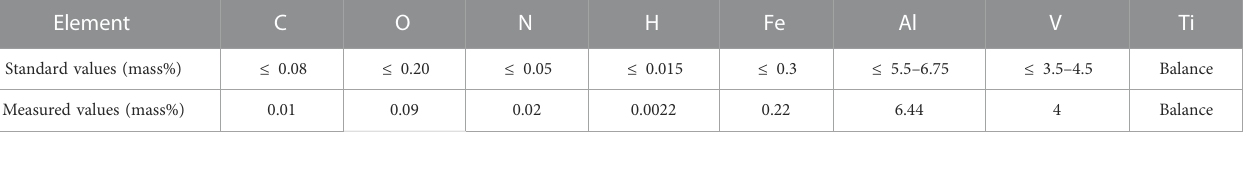
TABLE 4 Laser parameters employed for manufacturing Ti6Al4V porous hip stem.